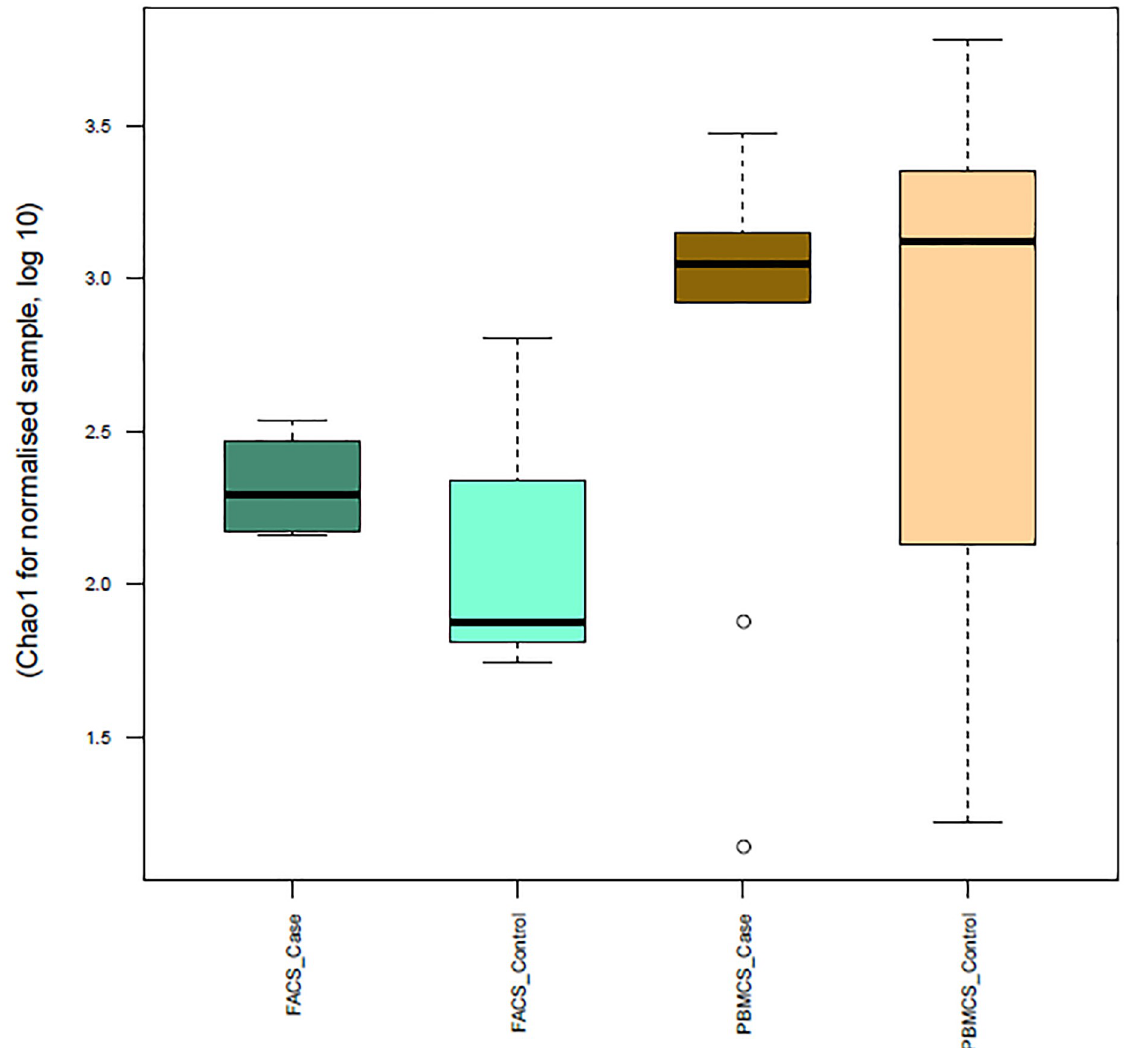
Fig 3. TCR Repertoire diversity estimation. Boxplot of chao1 estimator for normalised samples were used to assess the diversity of TCR repertoire in cases and control. PBMC: total blood cells. FACs: Sorting for Treg cells by FACs analysis.